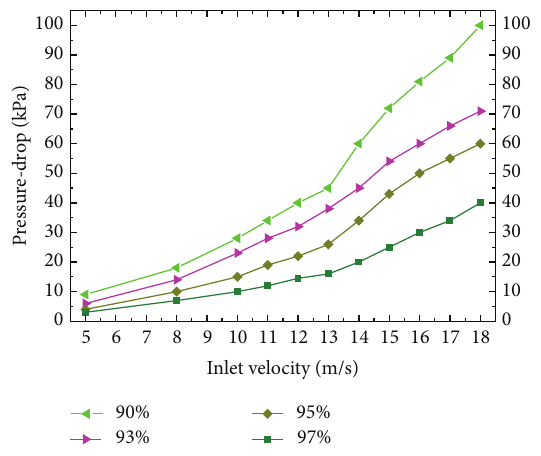
Figure 13: The influence of gas void fraction on